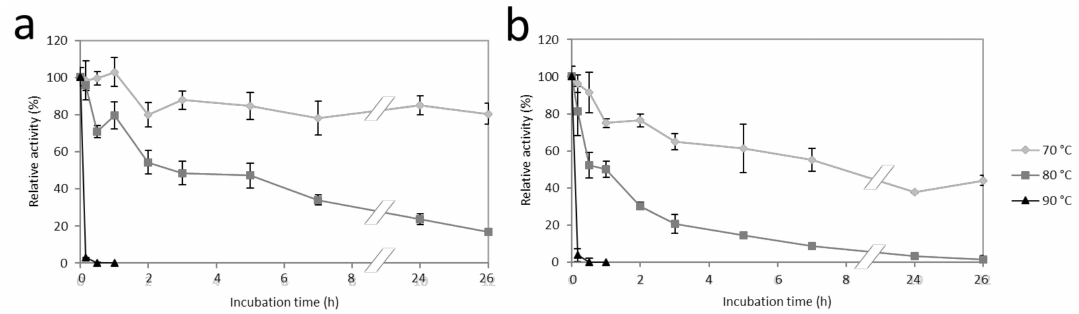
Figure 7. Influence of temperature on the stability of FLamA ( a ) and FLamB ( b ).